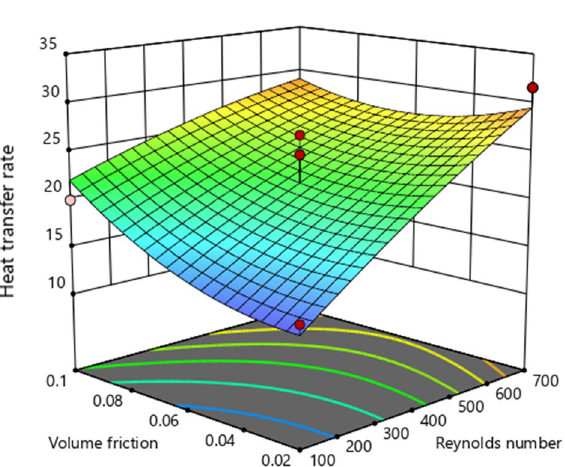
Figure 14. 3D graphs of heat transfer rate (Nusselt number) versus volume friction and Reynolds